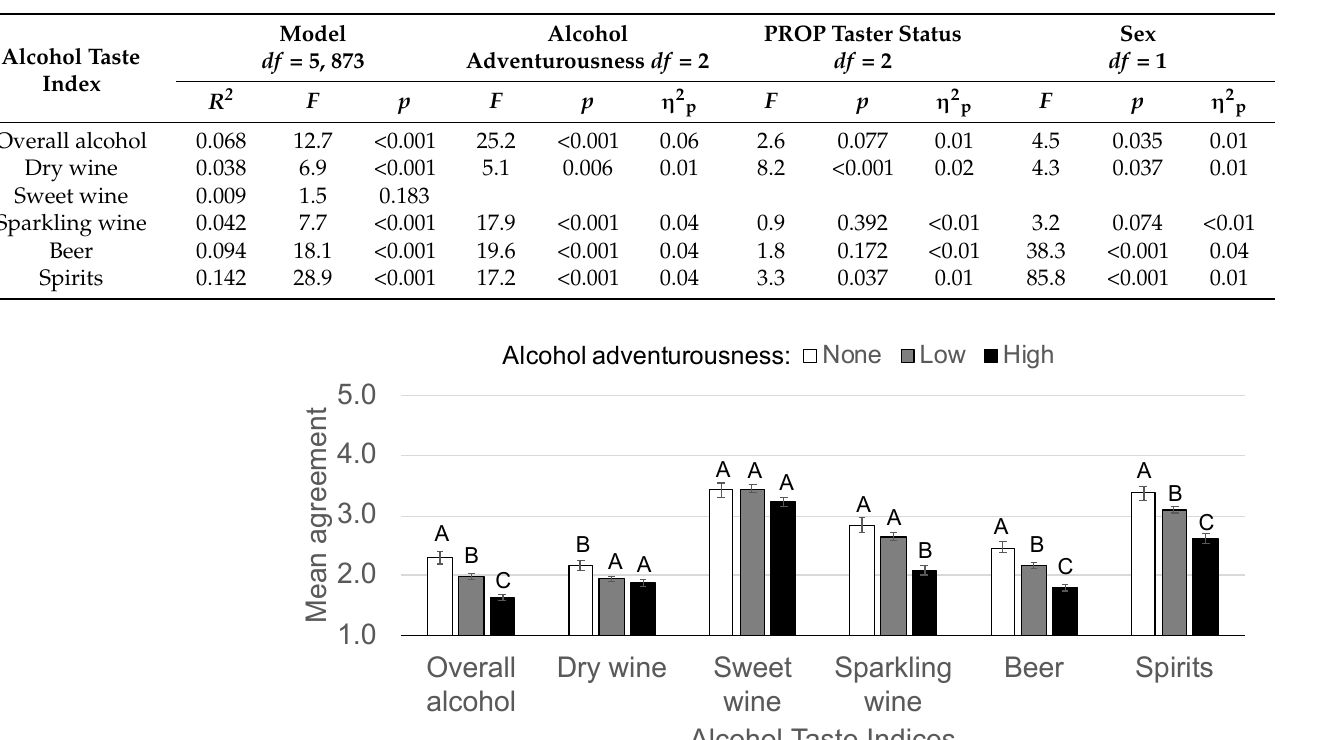
Table 4. Summary of three-way ANOVAs where alcohol taste indices were the dependent variables and alcohol adventur- ousness (none, low, high), PROP taster status (pNT, pMT, pST), and sex (male, female) were the independent variables.